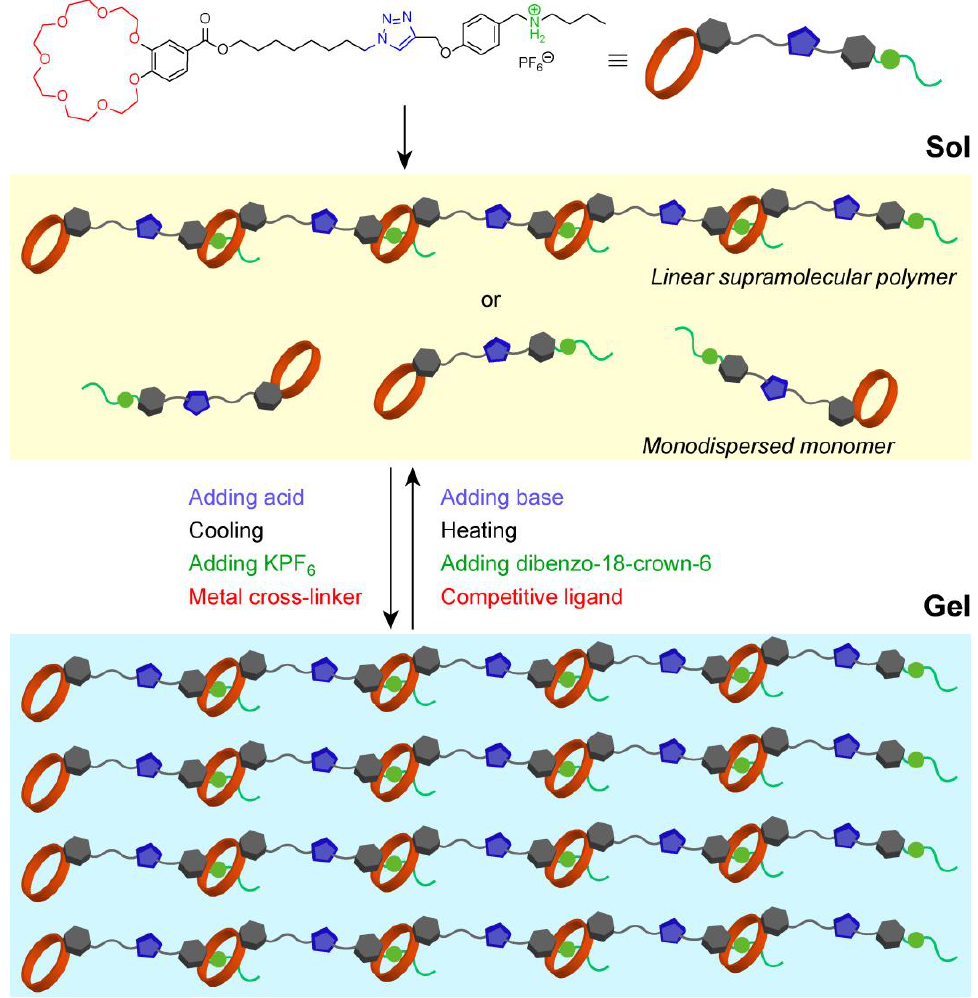
Figure 1. Schematic illustration of sol-gel transition from the collapse and formation of supramolecular polymers in response to pH, heat, cationic species, and metal ions. In particular, the self-healing ability (that is, the ability to spontaneously self-repair after being damaged) is an emergent function that appears through the skillful control of terials [18,19]. The main gels developed thus far are those mediated by bonds that recon-